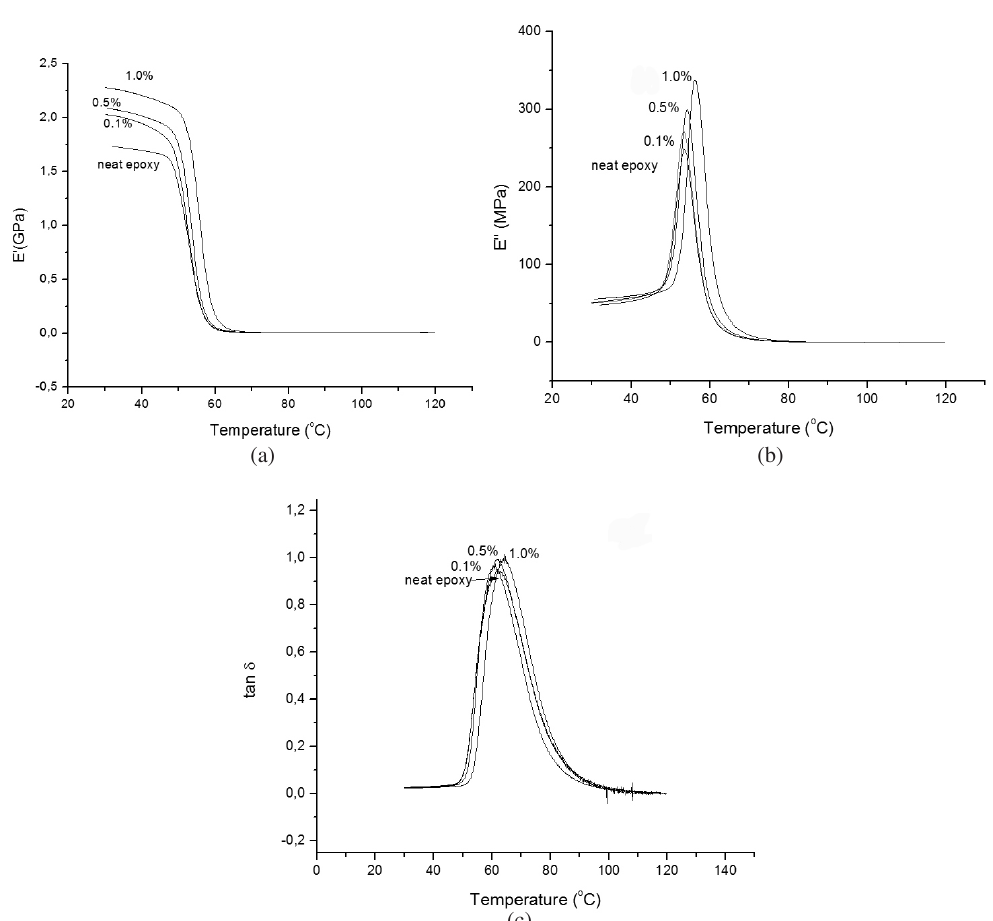
Figure 6. DMA results for nanostructured composites CNT/epoxy: (a) storage modulus (E’), (b) loss modulus (E”) and (c) tan δ as function of Table 1. DMA measurements for nanostructured composites CNT/ epoxy (E’ and E” reported at 30 °C). % (w/w)